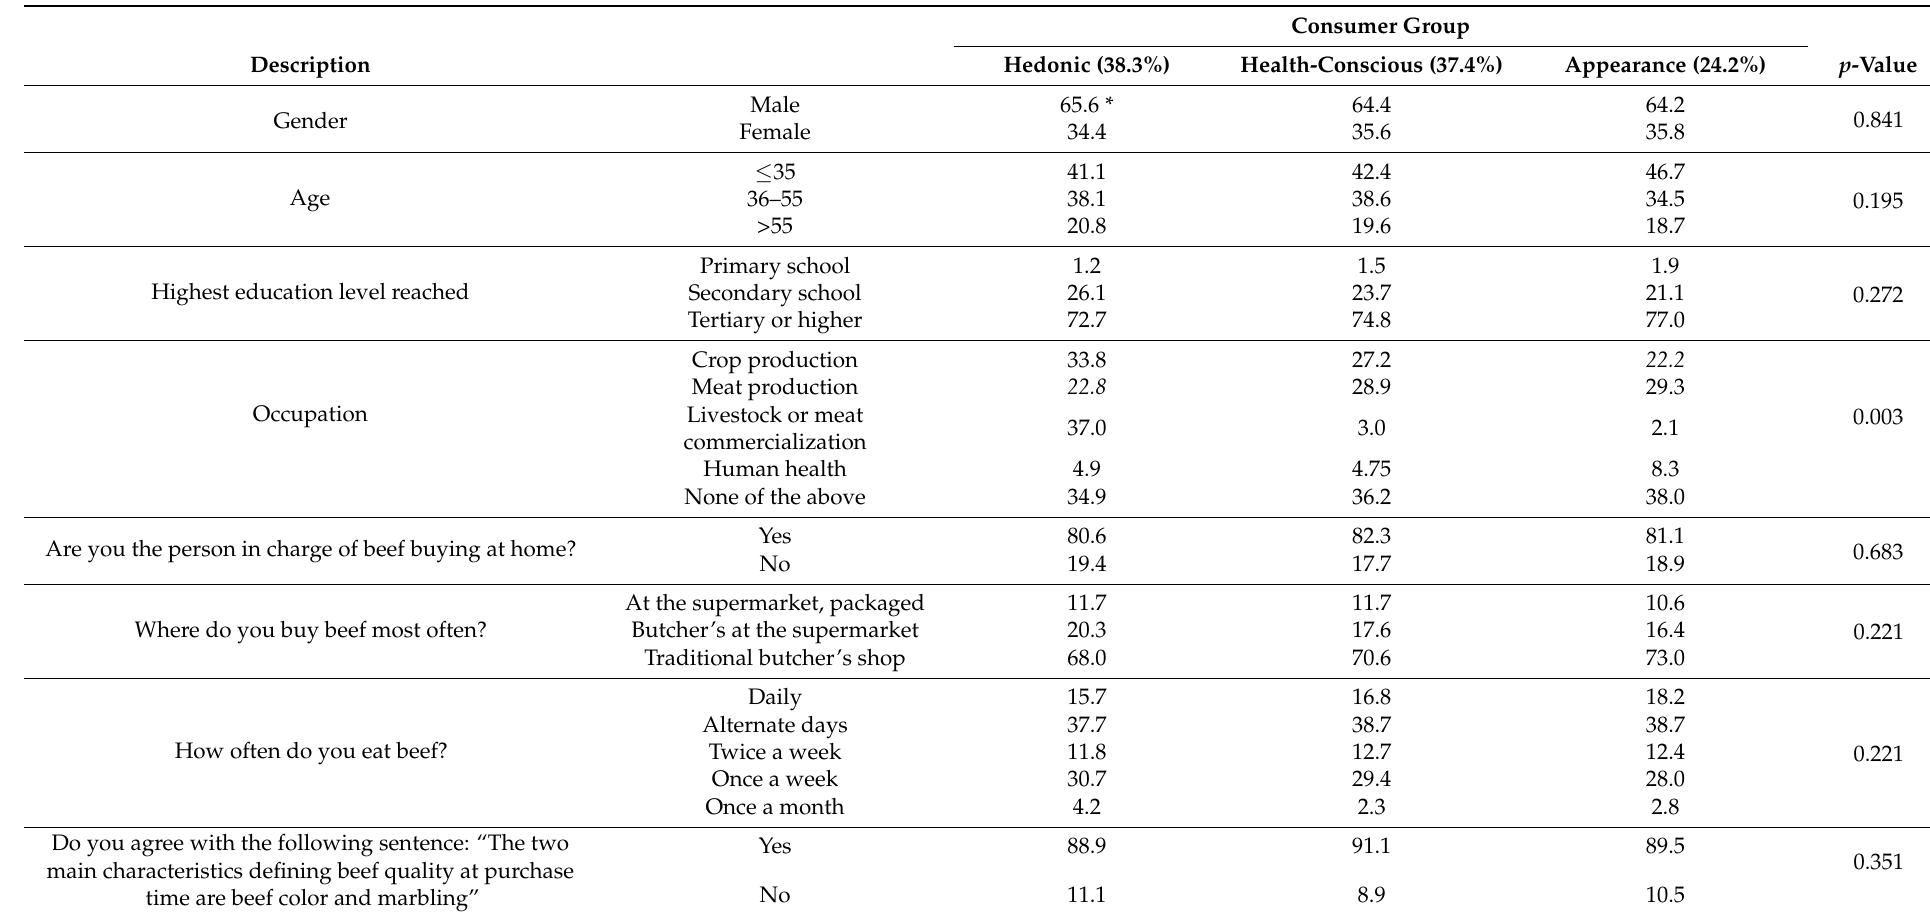
Table 7. Percentages of each socio-demographic characteristic, purchase habits, and beliefs for each of the consumer groups obtained in the cluster analysis.